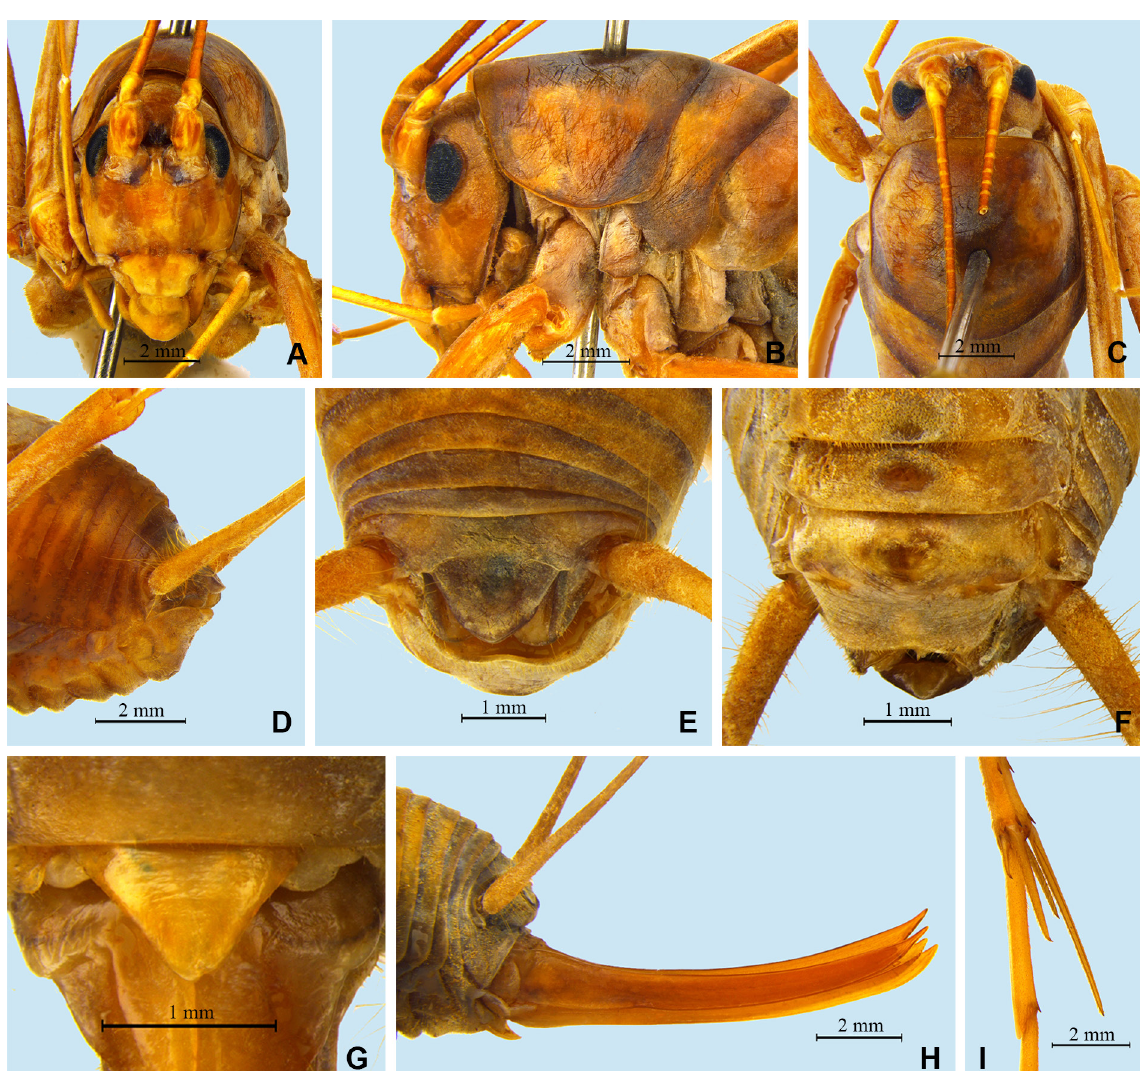
Fig. 6. Tachycines ( Gymnaeta ) latellai (Rampini & Di Russo, 2008). A–F, I . ♂. A–C . Head